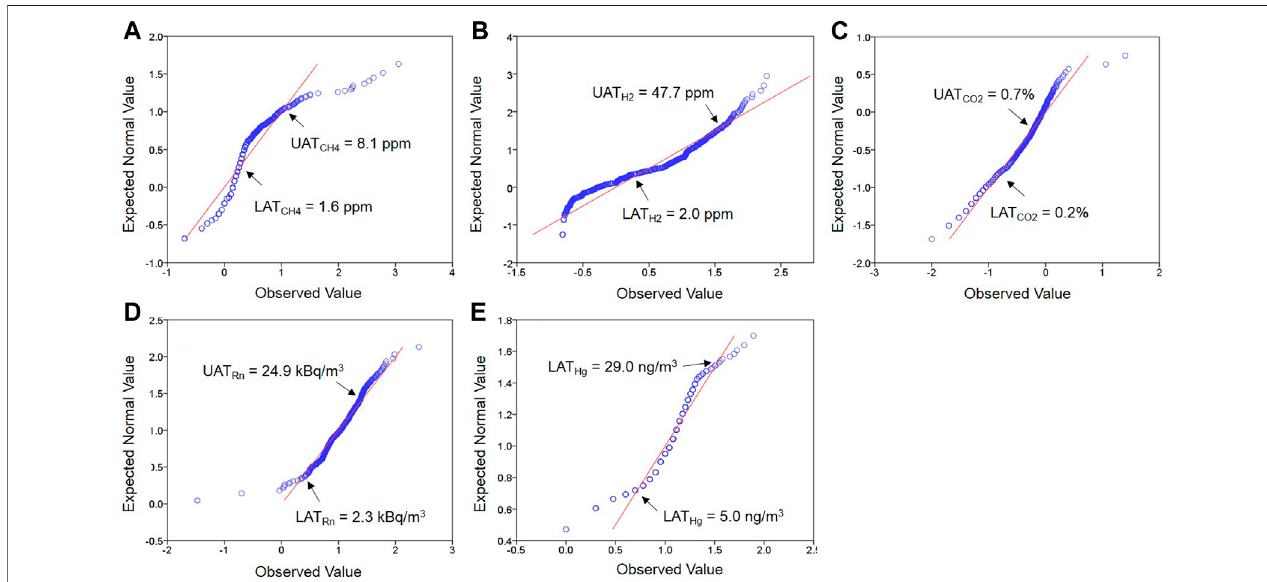
FIGURE 3 | Normal probability plots for: (A) , CH 4 ; (B) , H 2 ; (C) , CO 2 ; (D) , Rn; (E) , Hg.